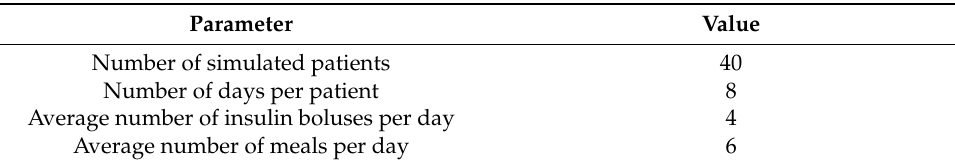
Table 1. Details for the dataset.